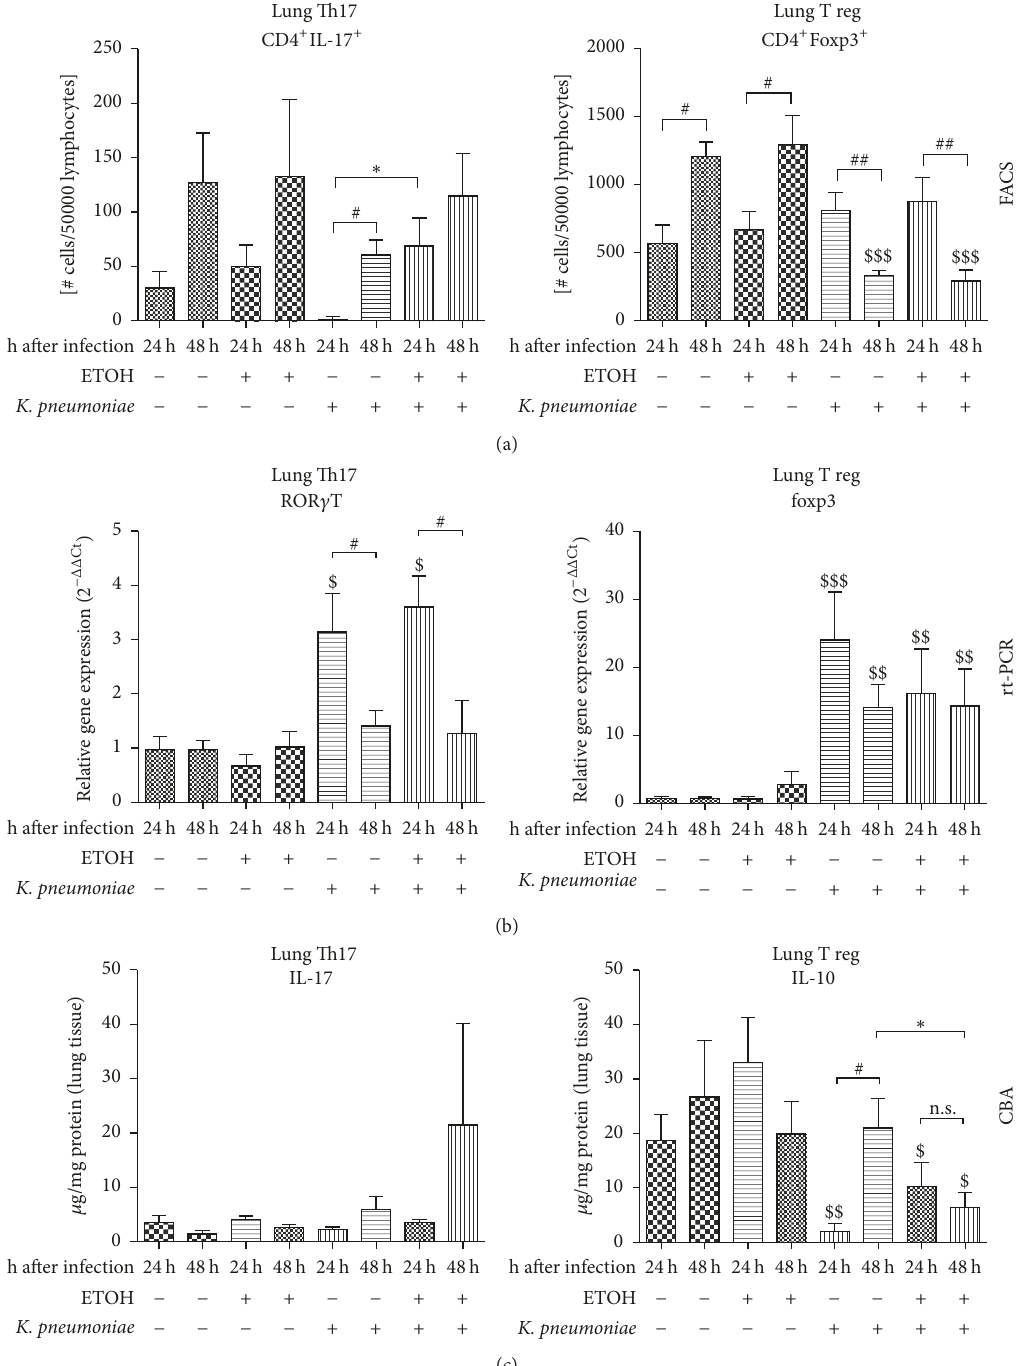
Figure 6: Flow cytometric analysis of indicated T helper cell subsets in the lung, relative gene expression of key transcription factors, and release of cytokine protein in a murine model of ethanol exposition for 2 weeks, surgery, and pulmonary infection. (a) Flow cytometric analysis of CD4 + /IL-17 + cells (left) and CD4 + /Foxp3 + cells (right) in the lung of ethanol-treated (ETOH) and saline-treated controls (NaCl) at24hoursor48hoursafterpulmonaryinfectionwith Klebsiellapneumoniae .Cellcountsaregivenasnumberofcellsper50.000lymphocytes. (b) Transcriptional regulation of indicated transcription factors assessed by real-time polymerase chain reaction. Expression of 𝛽 -actin served as housekeeping gene; expression of controls was set to 100%. (c) Protein levels of indicated cytokines were analyzed by cytometric bead array (CBA) and given as 𝜇 g/mg protein of lung tissue. ∗ 𝑝 < 0.05 when comparing ethanol treatment and saline-treated controls at the same time- point (ethanol-dependent effects); $ 𝑝 < 0.05 ; $$ 𝑝 < 0.01 ; $$$ 𝑝 < 0.001 when compared to time- and treatment-matched control (infection- dependent effects); # 𝑝 < 0.05 ; ## 𝑝 < 0.01 when comparing 24 hours to 48 hours (time-dependent effects); data are presented as mean ± SEM, Mann–Whitney U test ( 𝑛 = 8 each group). n.s.: not significant; CD: cluster of differentiation; ROR 𝛾 T : retinoid orphan receptor gamma T transcription factor; foxp3 : forkhead box p3 T-cell-specific transcription factor; IL: interleukin; ETOH: ethanol treatment; K . pneumoniae : pulmonary infection with Klebsiella pneumoniae